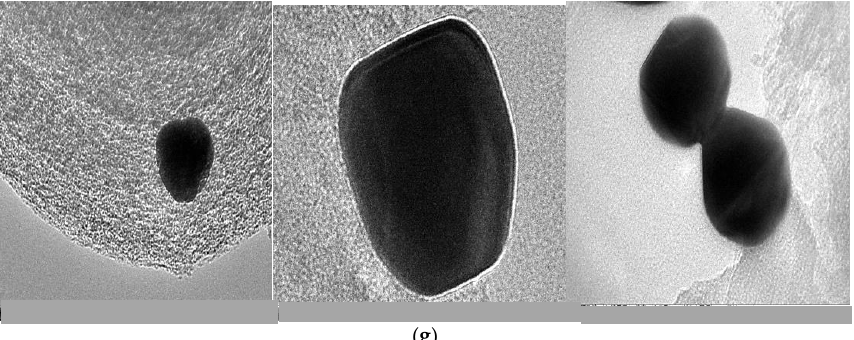
Figure 3. ( a ). TEM images and Au particle size distribution of fresh Au-en/SBA-15; mean size 60 Å ; ( b ) TEM images of spent Au-en/SBA-15; ( c ) TEM images and Au particle size distribution of fresh Au-0.6Mdp/SBA-15; mean size 19 Å ; ( d ) TEM images of spent Au-0.6Mdp/SBA-15; ( e ) TEM images and Au particle size distribution of fresh Au-0.6Adp/SBA-15; mean size 214 Å ; ( f ) TEM images and Au particle size distribution of fresh Au-P/SBA-15; mean size 556 Å ; ( g ) TEM images of spent Au-P/SBA-15. The nature and the size of the Au nanoparticles along with Au dispersion were also assessed through EXAFS and XRD measurements and data analysis. As seen in Figure 4, for all tested samples, metallic gold only was identified from the EXAFS spectra taken against the Au foil.